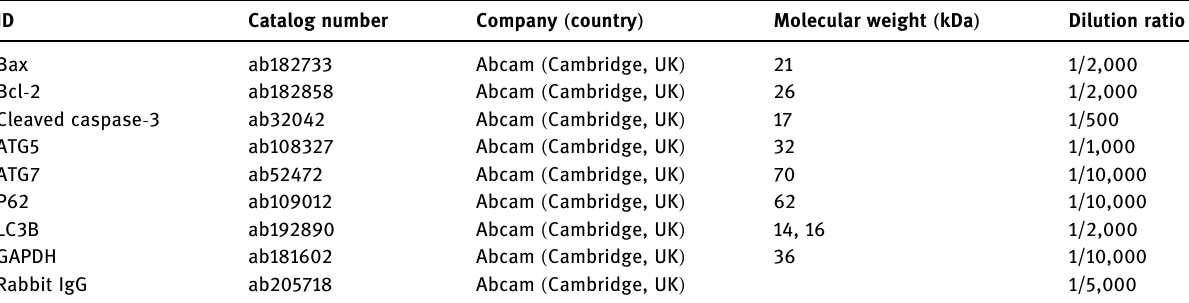
Table 2: All antibodies information and sources in Western blot in this